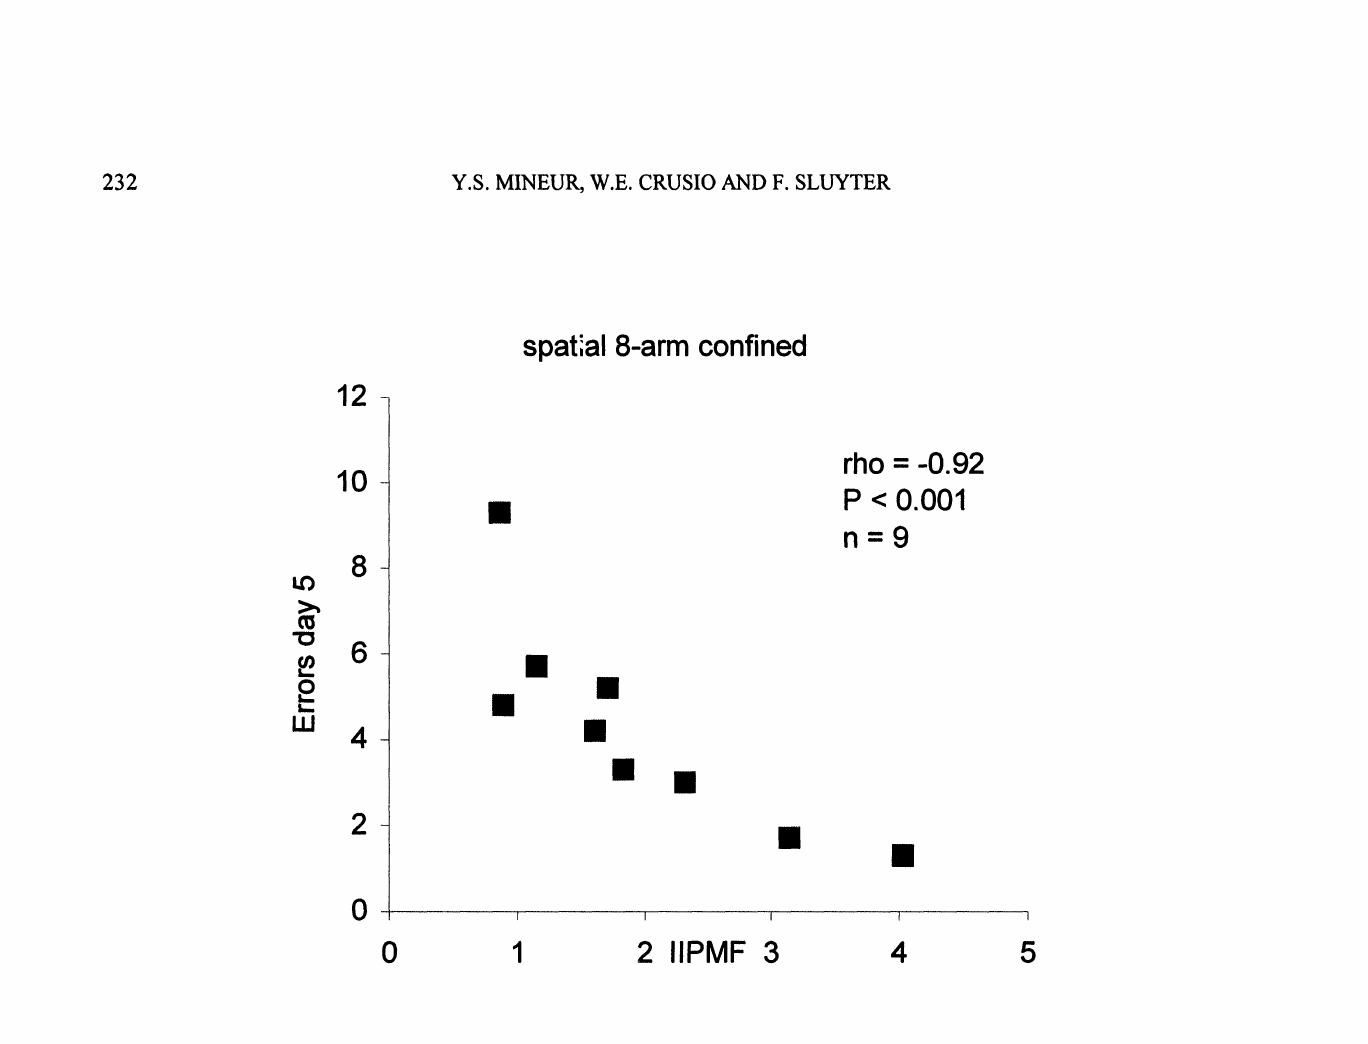
Fig. 2: Correlation between numbers of errors (repeat entrances) on the fifth daily trial in an 8-arm radial maze and hippocampal intra- and infrapyramidal mossy fiber extent (IIPMF). Data from Schwegler et al. (1990). Points represent means of 6 animals per